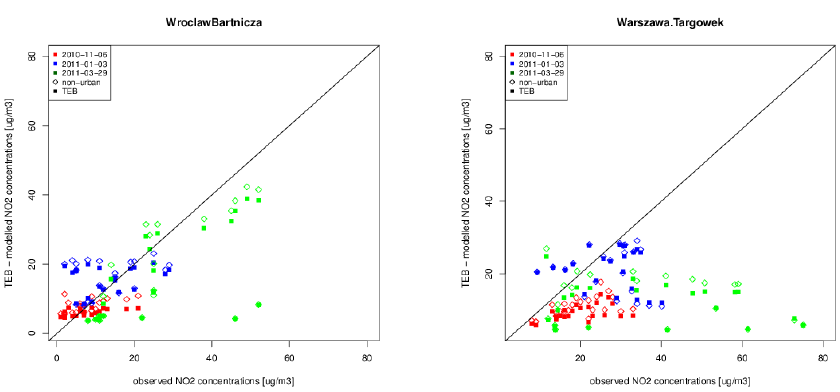
Figure 19 Near surface NO 2 concentrations measured at Wroclaw-Bartnicza and Warsaw- Fig. 19. Near surface NO 2 concentrations measured at Wroclaw-Bartnicza and Warsaw-Targowek air-quality monitoring stations and cal- culated with the GEM-AQ. Full colour with the TEB parameterization and the reference case outlined colour, red: 6 November 2010; blue: Targowek air-quality monitoring stations and calculated with the GEM-AQ. Full colour with 3 January 2011; green: 29 March the TEB parameterization and the reference case outlined colour, red: 6 th November 2010; blue: 3 rd January 2011; green: 29 th March 2011. 804